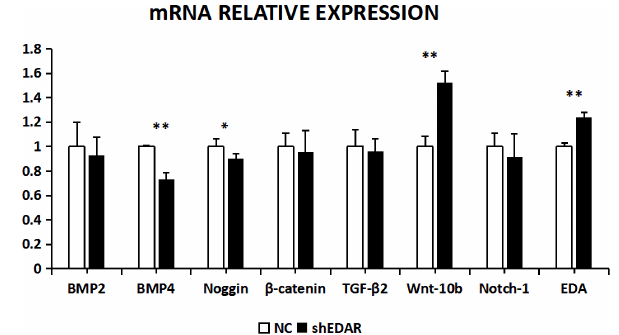
Figure 7. The mRNA relative expression of BMP2, BMP4, noggin, β -catenin, TGF- β 2, Wnt-10b, NOTCH1, and EDAR after EDA in- terference Note: ∗ significant difference. ∗∗ Extremely significant difference.